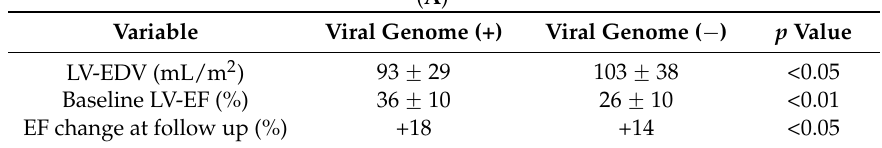
Table 3. ( A ) Echocardiographic features according to the presence or absence of viral genome at endomyocardial biopsies (EMB); ( B ) Echocardiographic features according to the